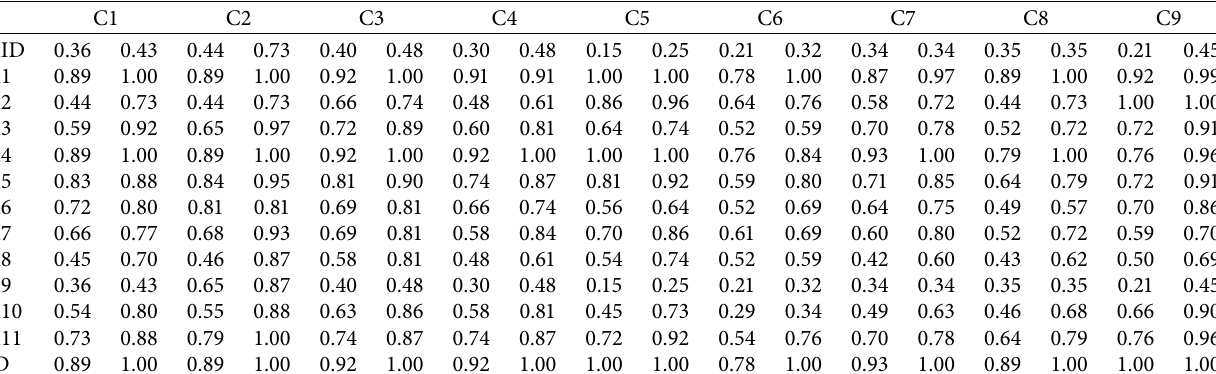
Table 11: Rough Normalized Matrix.